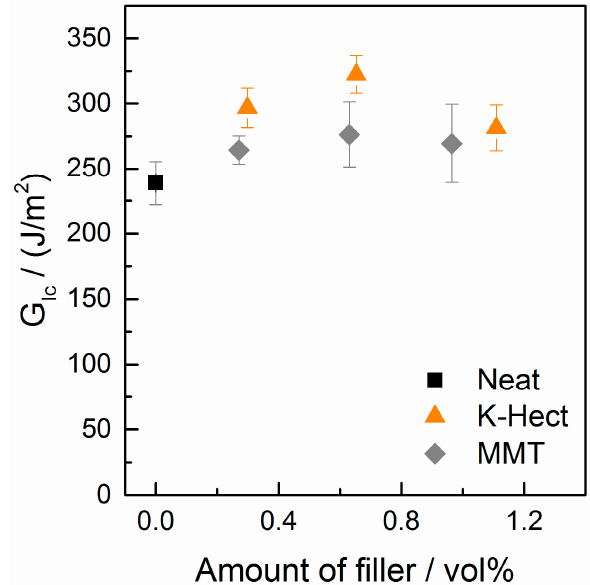
Figure 7. Energy release rate of mode I of laminates with di ff erent amounts of MMT or K-Hect.